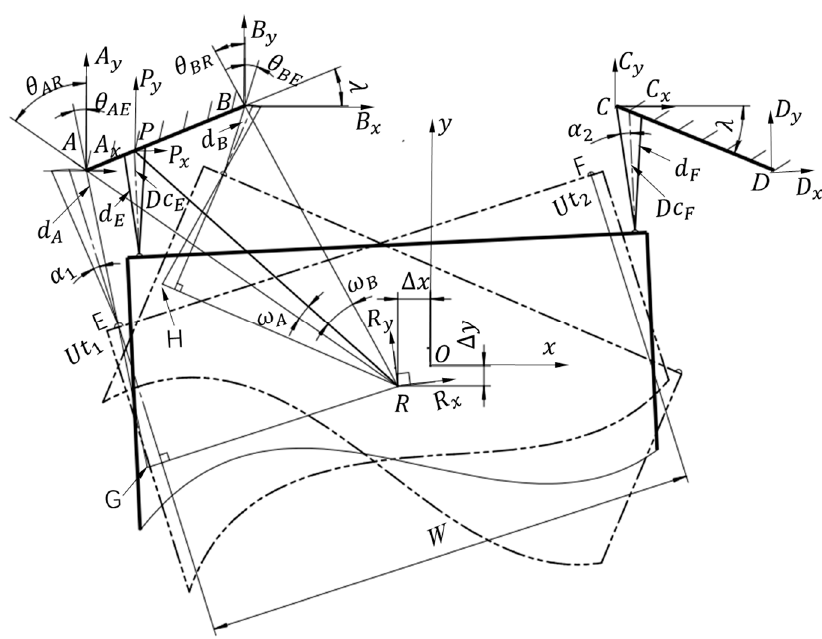
Figure 4. Localization model of the mobile robot.